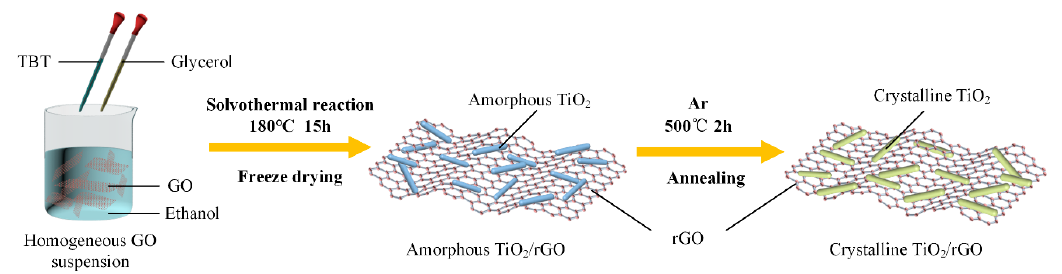
Figure 1. Schematic illustration of formation process for a-TiO 2 /rGO and c-TiO 2 /rGO composites.